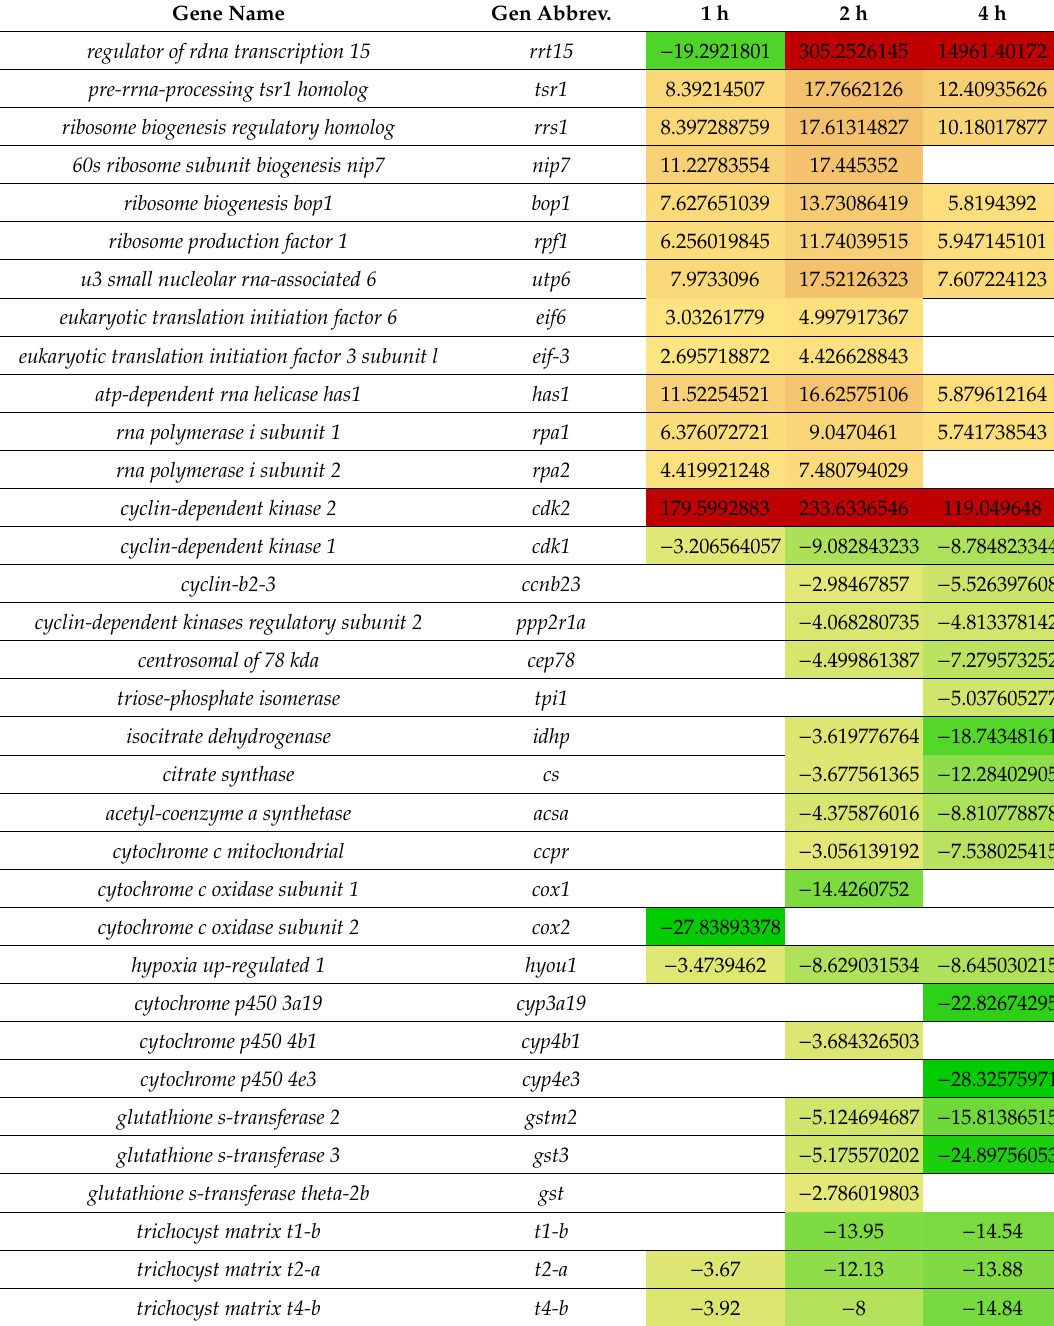
Table 2. Heat map showing a group of DE genes in P. dicentrarchi, including genes related to ribosome biogenesis, DNA transcription, cell cycle, metabolism, mitochondrial respiratory chain and detoxification, at 1, 2 and 4 hpi. Results are expressed as mean expression ratios of groups 1, 2, and 4 hpi vs. 0 h. Red indicates increased gene expression levels; green indicates decreased